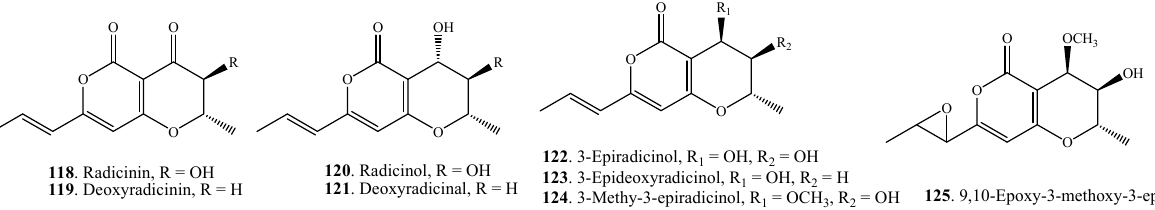
Figure 6. Simple pyranones isolated from Alternaria